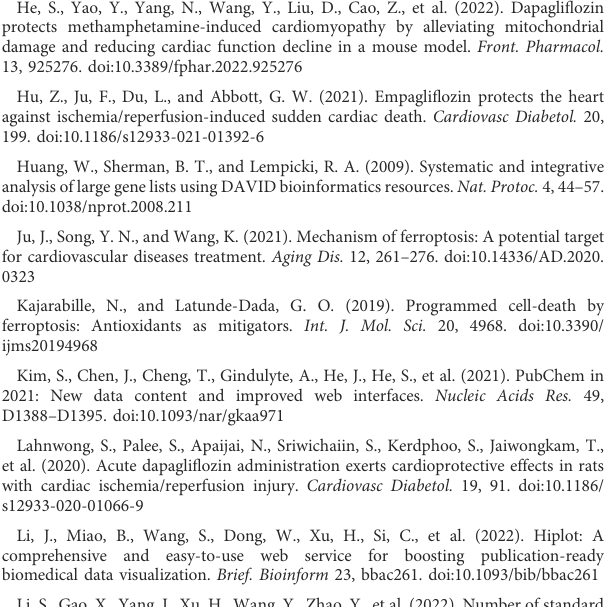
SUPPLEMENTARY FIGURE S1 PPI network and potential protein functional module. (A) PPI network of 26overlappingtargets. (B) Potential proteinfunctionalmodulewiththebest score in the PPI network. SUPPLEMENTARY TABLE S1 Primers for RT ‒